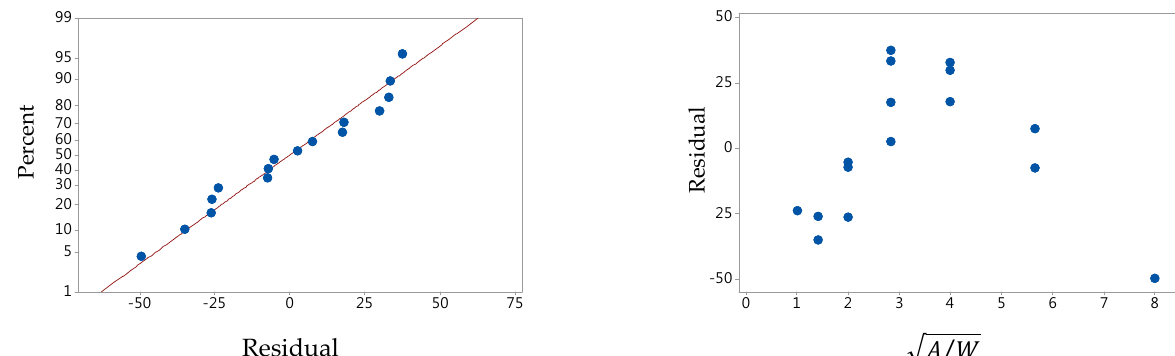
Figure 2. The normality plots of the residuals in the 1 oz stylus tapping task using the power model. The left side is residual vs. response percentage in the AD test; the right side is residual vs. A / W . The residuals changed the plus/minus signs as compared with Figure 1, and the plot pattern indicated violation of the assumption of independence.